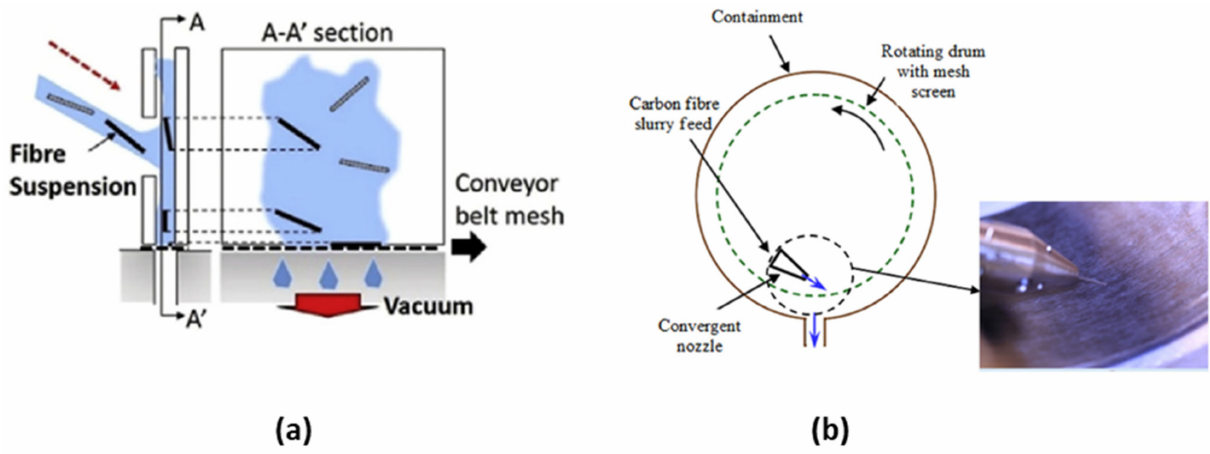
Figure 3. ( a ) HiPerDiF method of producing highly aligned preforms. Reprinted from [37]; ( b ) drum alignment method of producing highly aligned preforms. Reprinted with permission from [40]. Copyright 2021